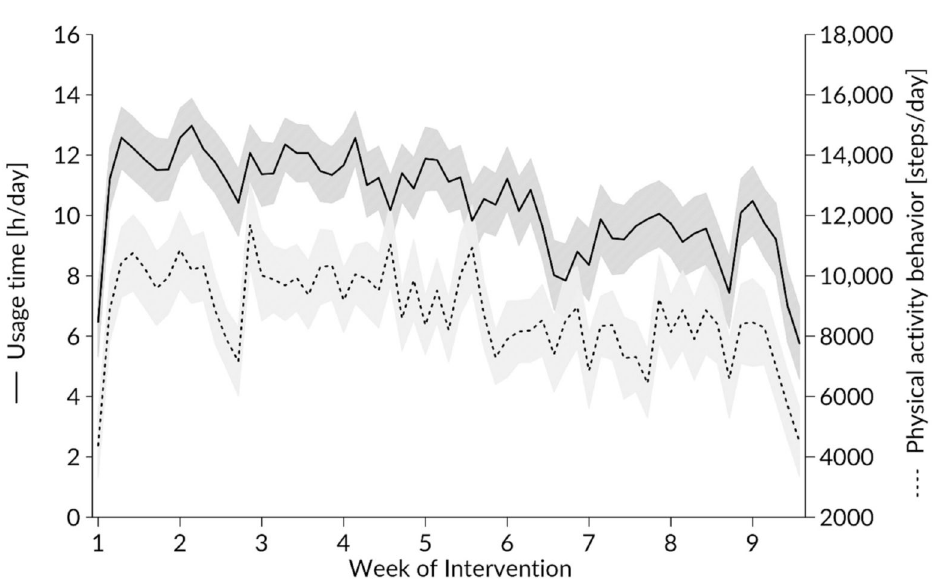
Figure 2. Average use per day of the intervention depicted as usage time (h / day) on the y-axis on the left-hand side and physical activity behavior (steps / day) on the y-axis on the right-hand